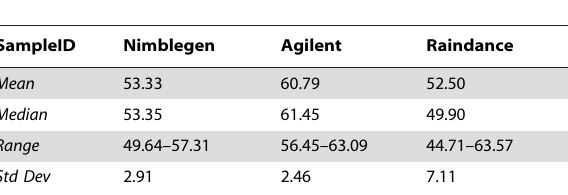
Table 3. Percent on-target, matched sample sets (N =6).